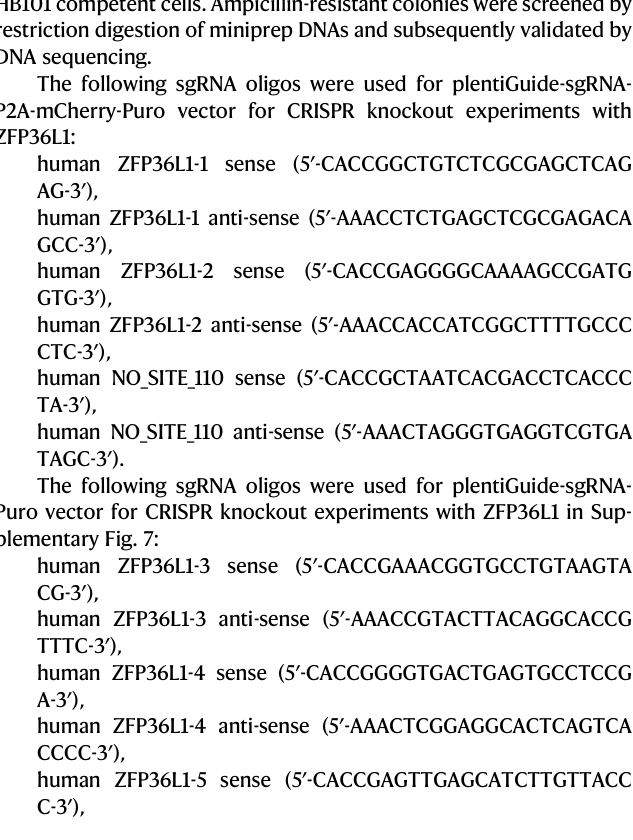
Fig. 4 | LSD1 inhibitors blockneuroendocrine differentiation and proliferation in small-cell lung cancer through a ZFP36L1-dependent mechanism. a , b Immunoblot analysis of NCI-H1876 cells ( a ) and CORL47 cells ( b ) treated with ORY-1001 (100nM) for 6, 7, and 8 days. c – e Immunoblotanalysis ( c ),RT-qPCR( d